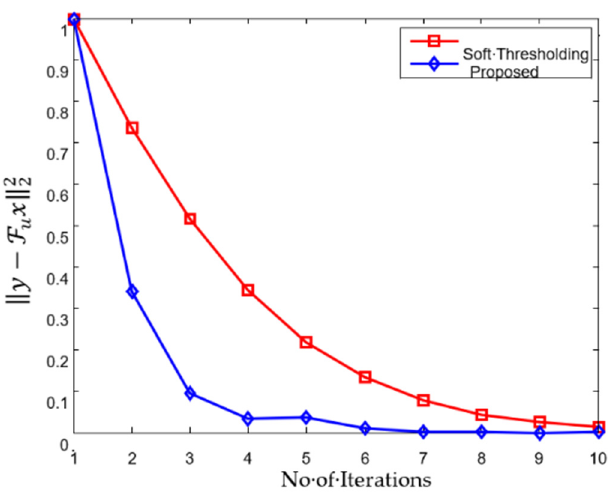
Figure 14. Comparison of cardiac cine MRI recovery at number of iterations; it can be seen from results that proposed method converges to an optimal solution in lesser iterations as compared to traditional thresholding.